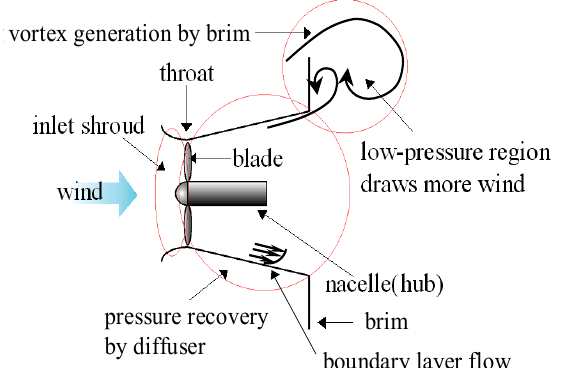
Figure 2. Characteristics of flow around a Wind-Lens